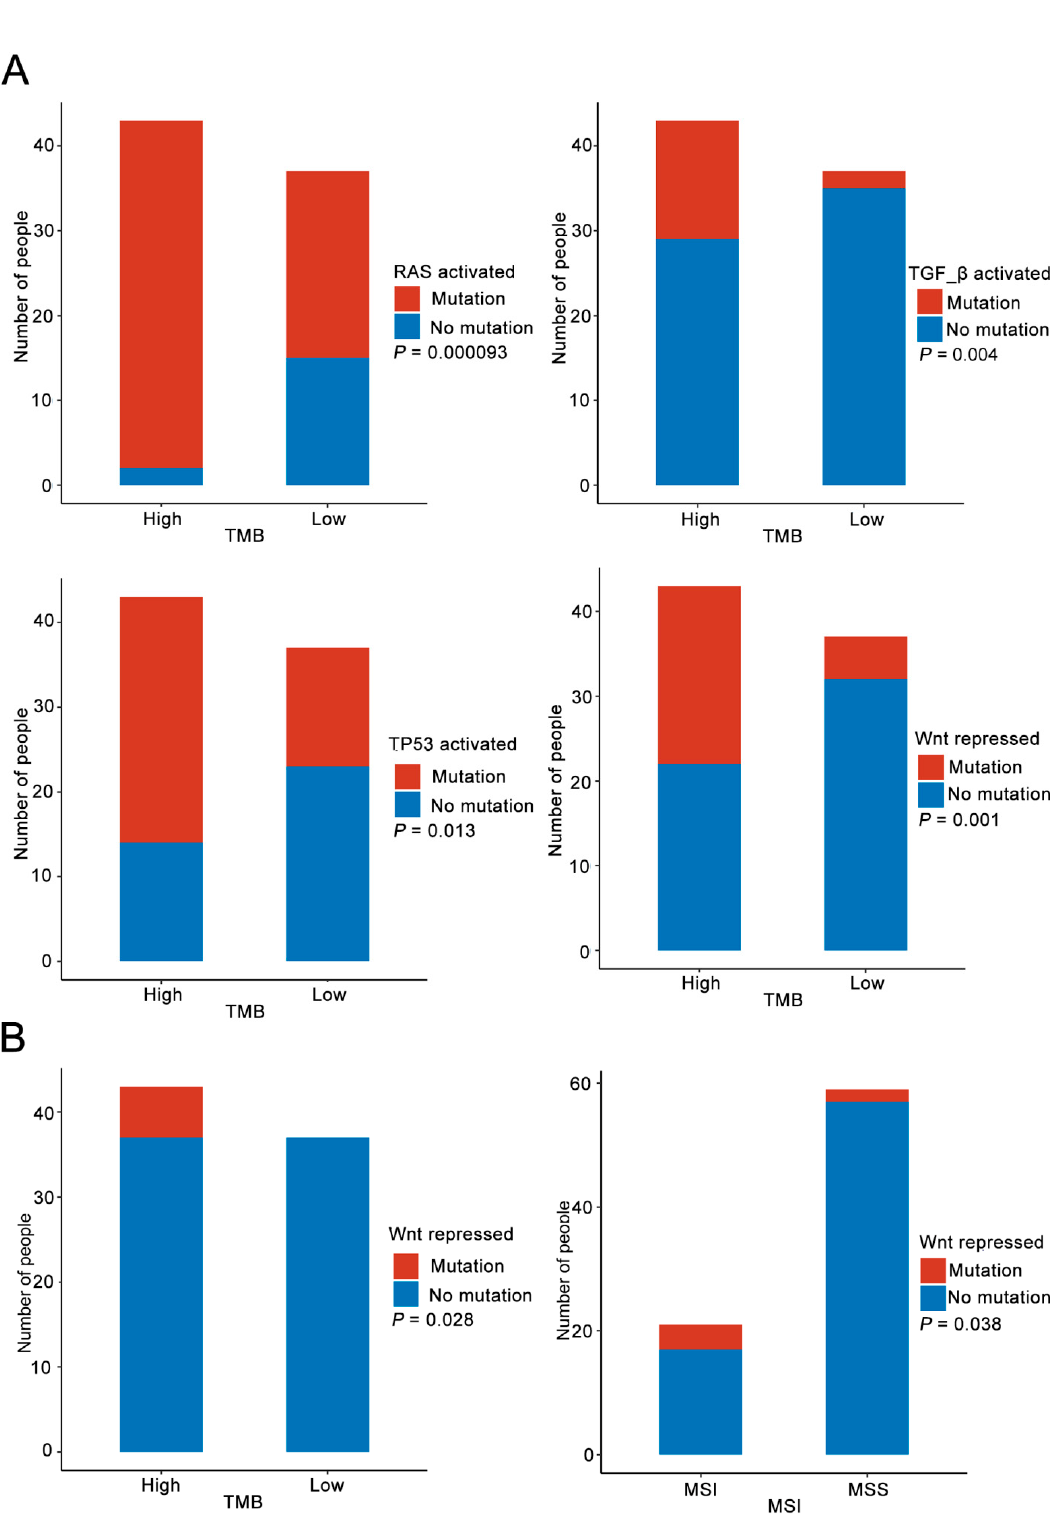
Figure 5. Analysis of differences in immune-related pathway. ( A ) The difference in the number of people with all the mutation genes related to RAS-activated, TGFB-activated, TP53-activated and Wnt-repressed pathway between TMB-L and TMB-H groups. ( B ) The difference in the number of people with 27 common genes related to Wnt-repressed pathway between TMB-L and TMB-H groups and MSI and MSS groups.